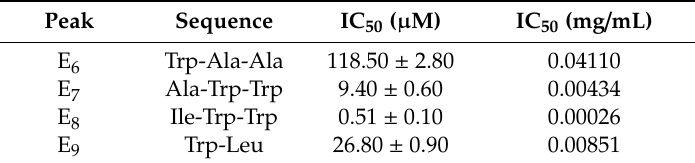
Table 5. Identification of peptide sequences from E6 to E9 peaks and their ACE IC 50 analysis. Peak Sequence IC 50 ( µ M) IC 50 (mg / mL) E 6 Trp-Ala-Ala 118.50 ± 2.80 0.04110 E 7 Ala-Trp-Trp 9.40 ± 0.60 0.00434 Ile-Trp-Trp 0.51 ± 0.10 0.00026 Trp-Leu 26.80 ± 0.90 0.00851 Values are averages of three